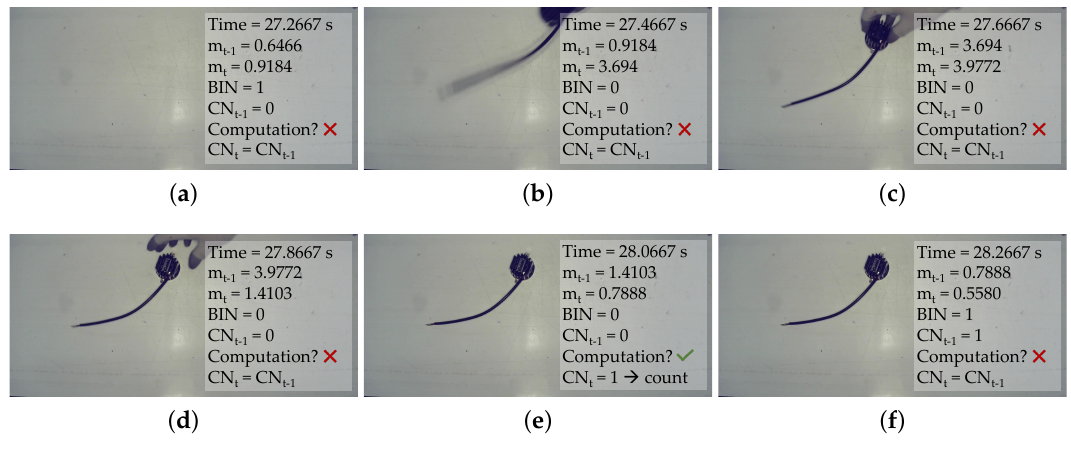
Figure 5. The sequence of placing one piece: ( a ) the last stand-still frame; ( b ) the first motion phase frame; ( c ) another motion phase frame; ( d ) another motion phase frame; ( e ) the first frame of a stand-still phase that is further processed; and ( f ) another stand-still phase frame , which is not further